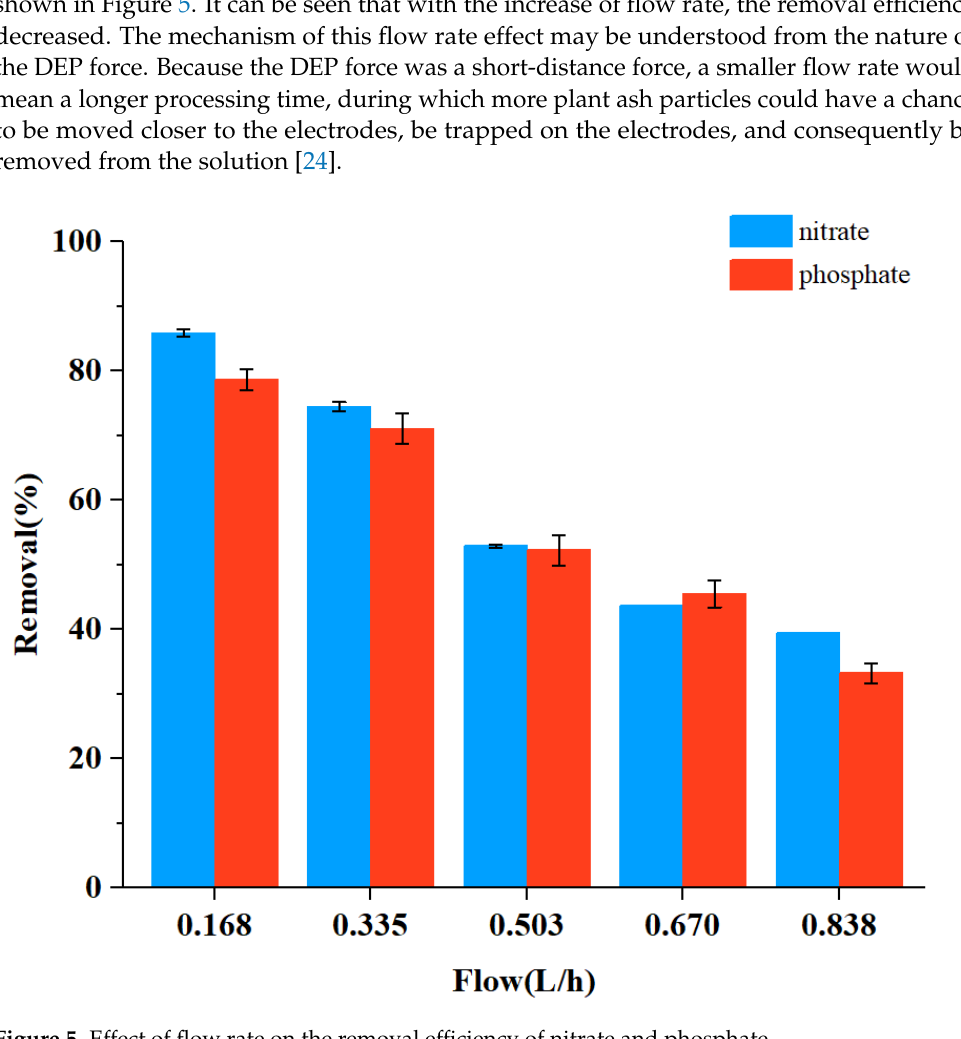
Figure 5. Effect of flow rate on the removal efficiency of nitrate and phosphate.